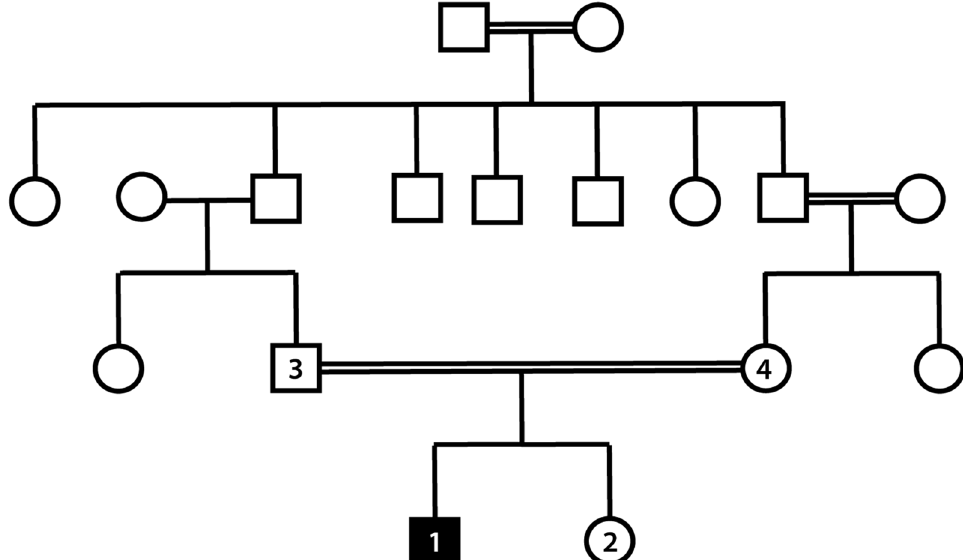
Fig. 1 Pedigree of family. Patient 1 was a 9‑year‑old affected male in the presented study. The parents of the affected son (3,4) are first